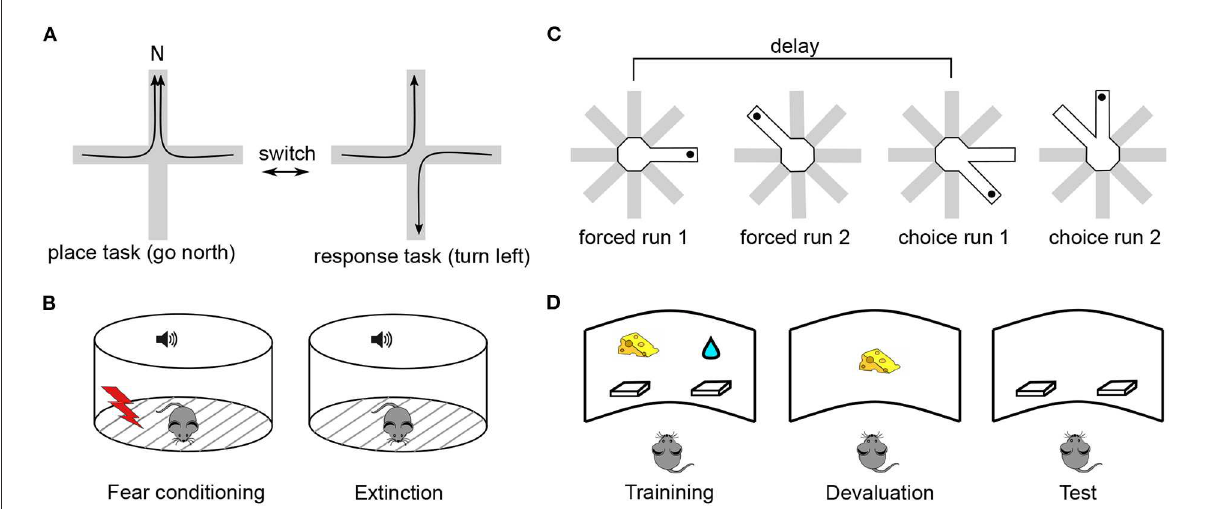
FIGURE1 Typical experimental paradigms in which performance depends on synaptic plasticity in the mPFC. (A) Strategy selection. Rodents are trained to switch between place and response tasks, following a switch of reward contingency (Rich and Shapiro, 2007). In the place task, animals are rewarded if they reach the same arm (e.g., N) starting from any other arm. In the response task, reward is given if animals perform the same body turn at the intersection point. Importantly, the contingency switch is not signalled by any external cue, the animals have to infer it via trial-and-error. In a set-shifting version of the task (Birrell and Brown, 2000), animals switch between decisions based on different types of cue (e.g., odor vs. texture), instead of spatial strategy. (B) Fear extinction. During a conditioning period, animals associate a neutral cue, e.g., a sound tone, with a footshock, so that they acquire a freezing response to the cue (Herry and Garcia, 2002). During an extinction period the cue is repeatedly presented without the footshock, so that animals “learn to forget” the freezing response. In a contextual fear conditioning, the fear response is associated with environmental features (e.g., its visual appearance) rather than a discrete cue (Bouton et al., 2011). (C) Delay-period working memory. In an 8-arm maze, animals retrieve a reward (black dot) from a single open arm (forced choice 1) (Touzani et al., 2007). After a delay, the same arm is open together with an adjacent one and the animal has to choose the non-visited arm to obtain the reward (choice run 1). In a more complicated version of the task, a second forced run is inserted during the delay so that the animal has to keep in memory the two arms and use this information after the corresponding delay. (D) Decision making. During a training phase, animals learn to press on either of the two levers to obtain distinct rewards associated with them (e.g., a food pellet or sucrose solution, Corbit and Balleine, 2003). During the following devaluation phase, the animals are fed to satiety on one of the two reward types. During test, no reward is given and the preponderance of the animals to press on either lever is measured. Goal-directed behavior corresponds to a less frequent use of the lever associated with the devaluated reward. In a more complex version of the task, one employs contingency degradation instead of reward devaluation. In that case, the animal is given a particular reward irrespective of whether it presses on the associated lever or not, leading to a less frequent use of this lever in normal